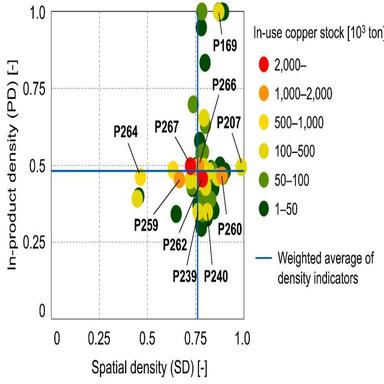
Scatter diagram for spatial and in-product densities of selected final products in Japan in 2011. The blue lines represent the weighted average values for all final products based on the amounts of in-use copper stocks for the spatial and in-product densities (0.76 for SD and 0.48 for PD).